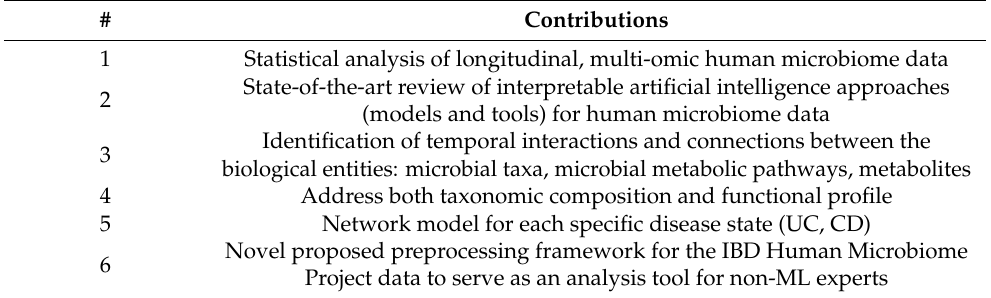
Table 2. Main contributions of this